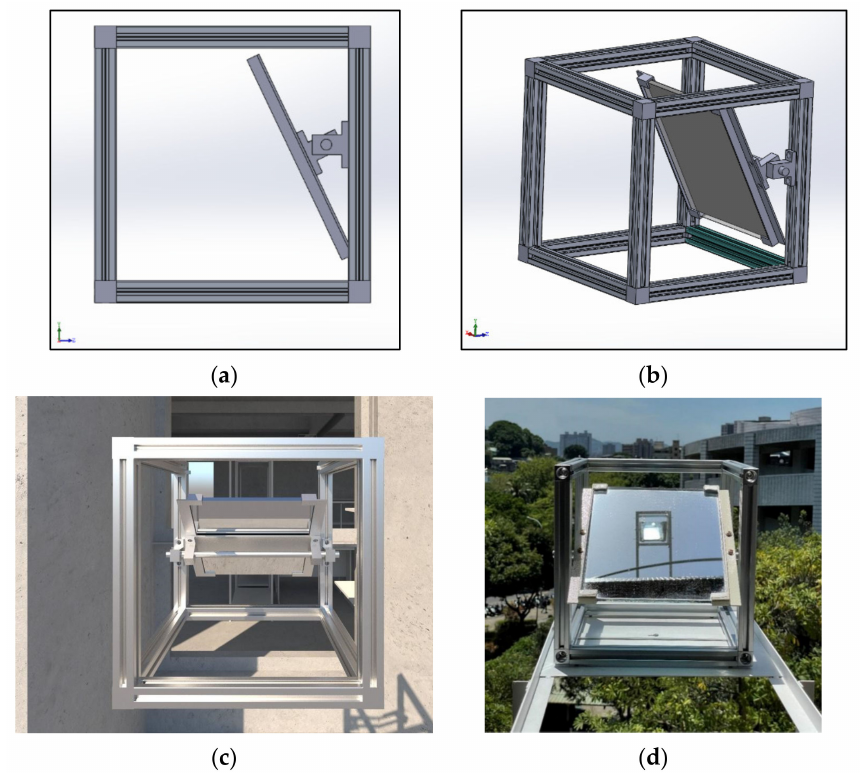
Figure 8. Perspective views of the light cube in CAD software ( a , b ) and the actual light cube in situ ( c , d